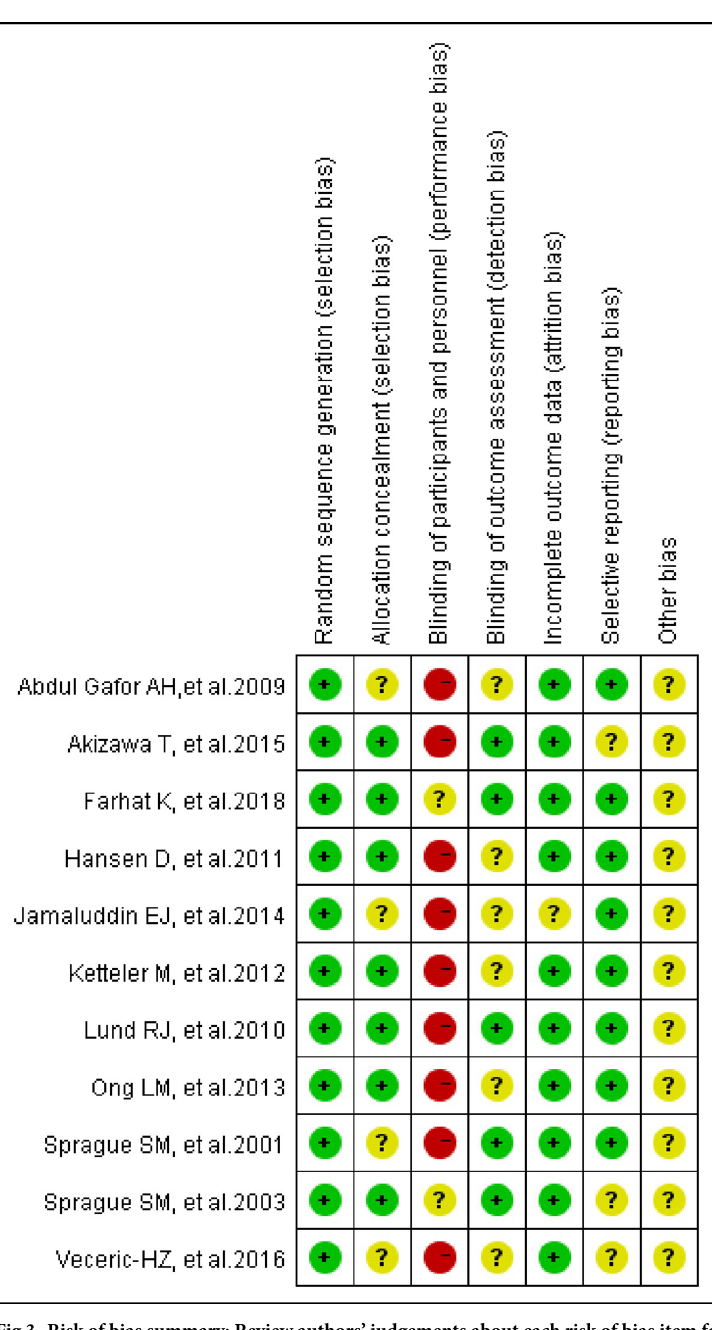
Fig 3. Risk of bias summary: Review authors’ judgements about each risk of bias item for each included study.